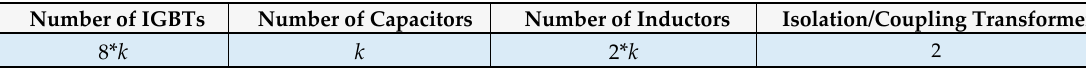
Figure 10. Modular RPC units (MRPC) with coupling transformers (based on [35]). Table 8. Components quantities of the MRPC.